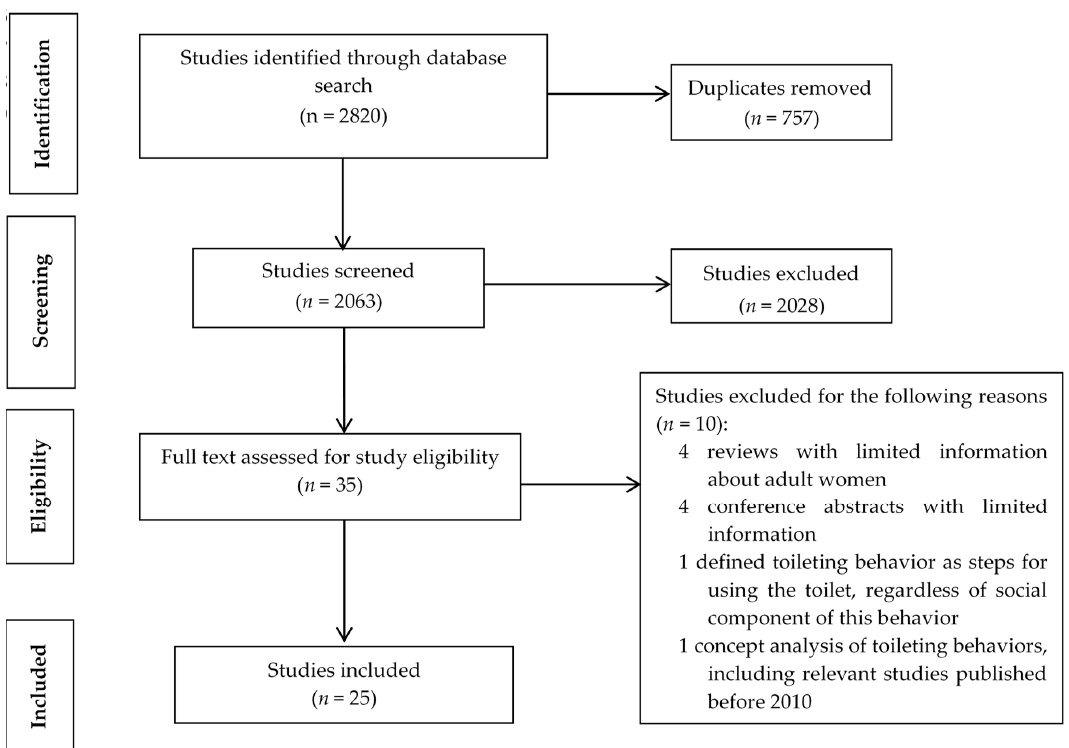
Figure 1. PRISMA flow diagram for inclusion of articles in scoping review.